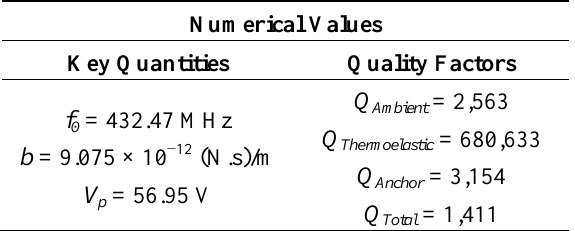
Table 2. The derived numerical values for nano-electro-mechanical (NEM)